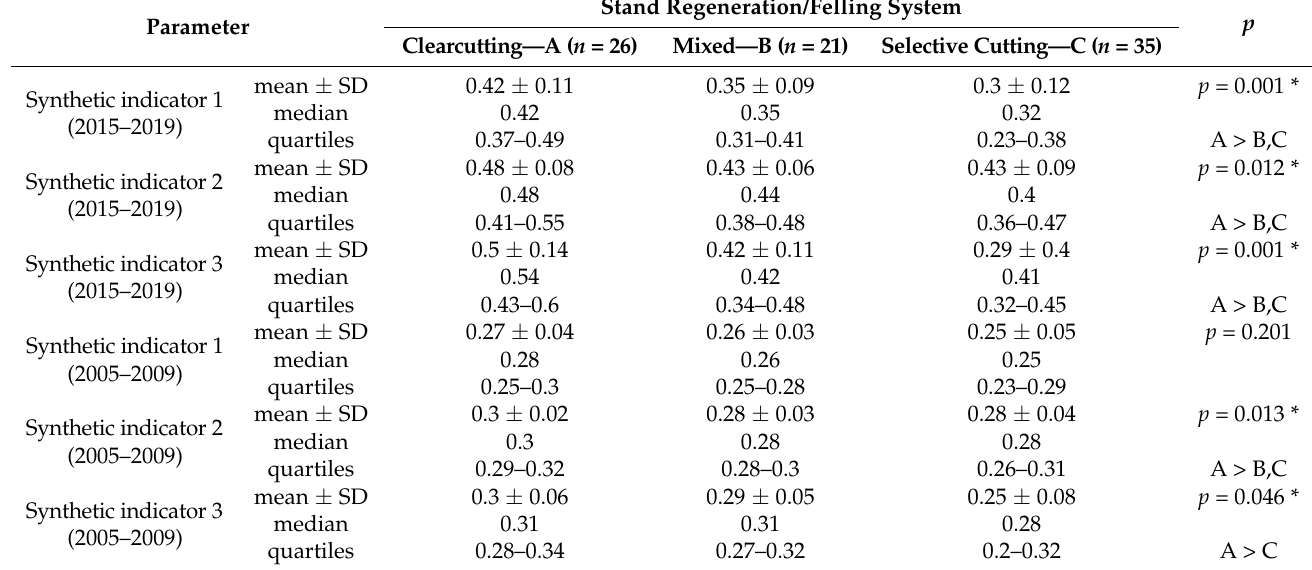
Table 6. Relationships between the synthetic indicators and forest district categories distinguished on the basis of stand regeneration/felling system.